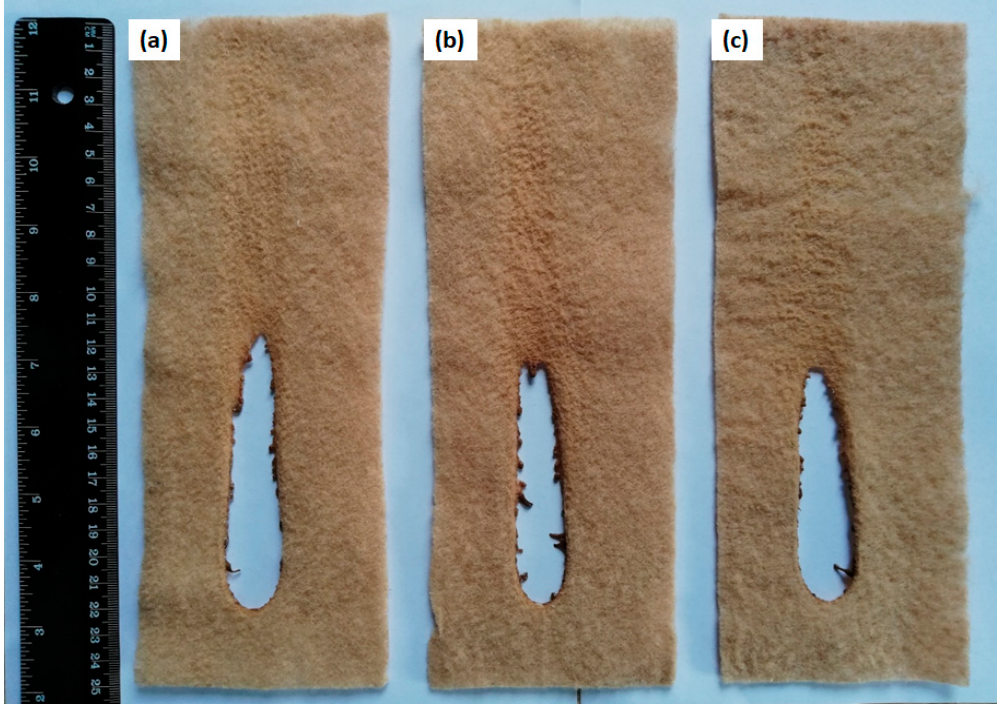
Figure 11. Images of PLA/APP5/PES10/KL1 ( a ), PLA/APP5/PES10/KL3 ( b ), PLA/APP5/PES10/KL5 ( c ) FR nonwoven fabric samples after ignitability test.